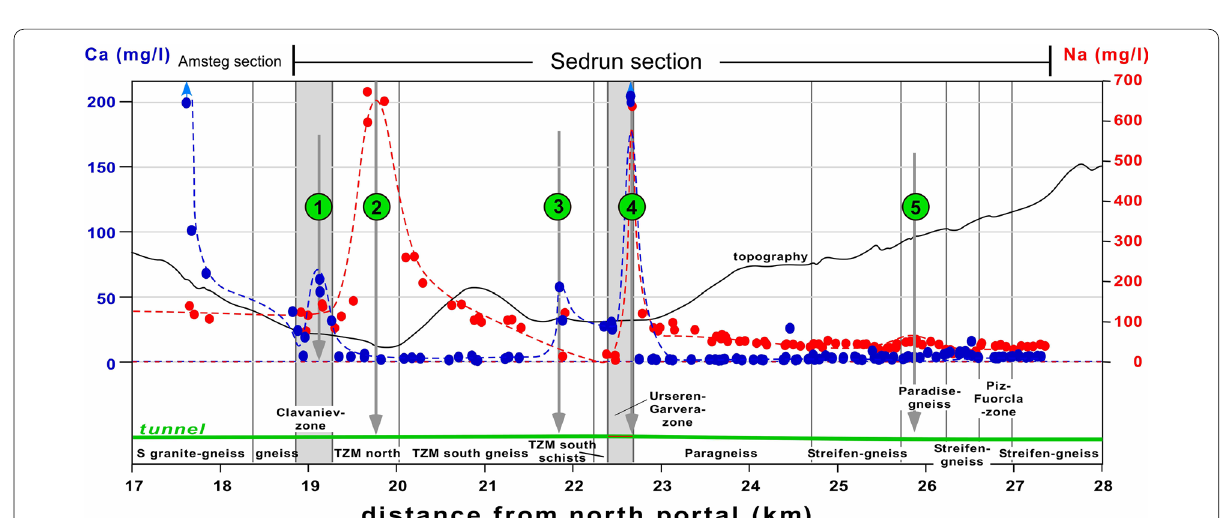
Fig. 7 Ca and Na concentration along the Sedrun Section: Numbers 1–6 in green circles: Strongly fractured zones with high discharge rates, high TDS and Cl (see discussion Sect.